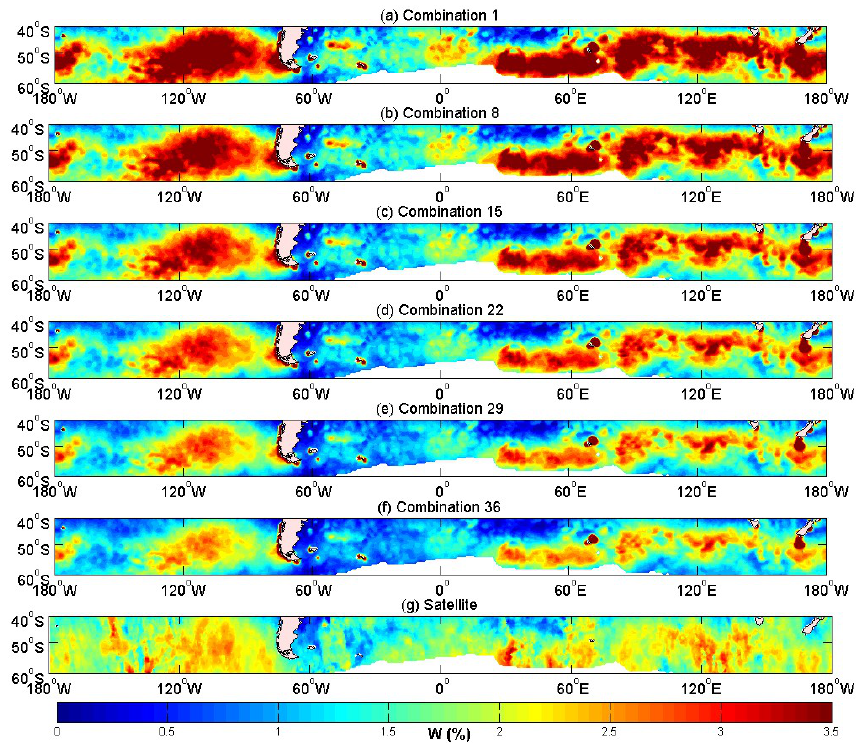
Figure 3. The whitecap coverage of the Equation (3) in October 2006 over 180° W–180° W,40° S–60° S for ( a ) Combination 1, θ = 8, ρ = 0.53; ( b ) Combination 8, θ = 8.6, ρ = 0.53; ( c ) Combination 15, θ = 9.2, ρ = 0.53; ( d ) Combination 22, θ = 9.8, ρ = 0.53; ( e ) Combination 29, θ = 10.4, ρ = 0.53; ( f ) Combination 36, θ = 11, ρ = 0.53; ( g ) satellite-derived result [20]. A unified scale colorbar with values from 0 to 3.5 % is used.